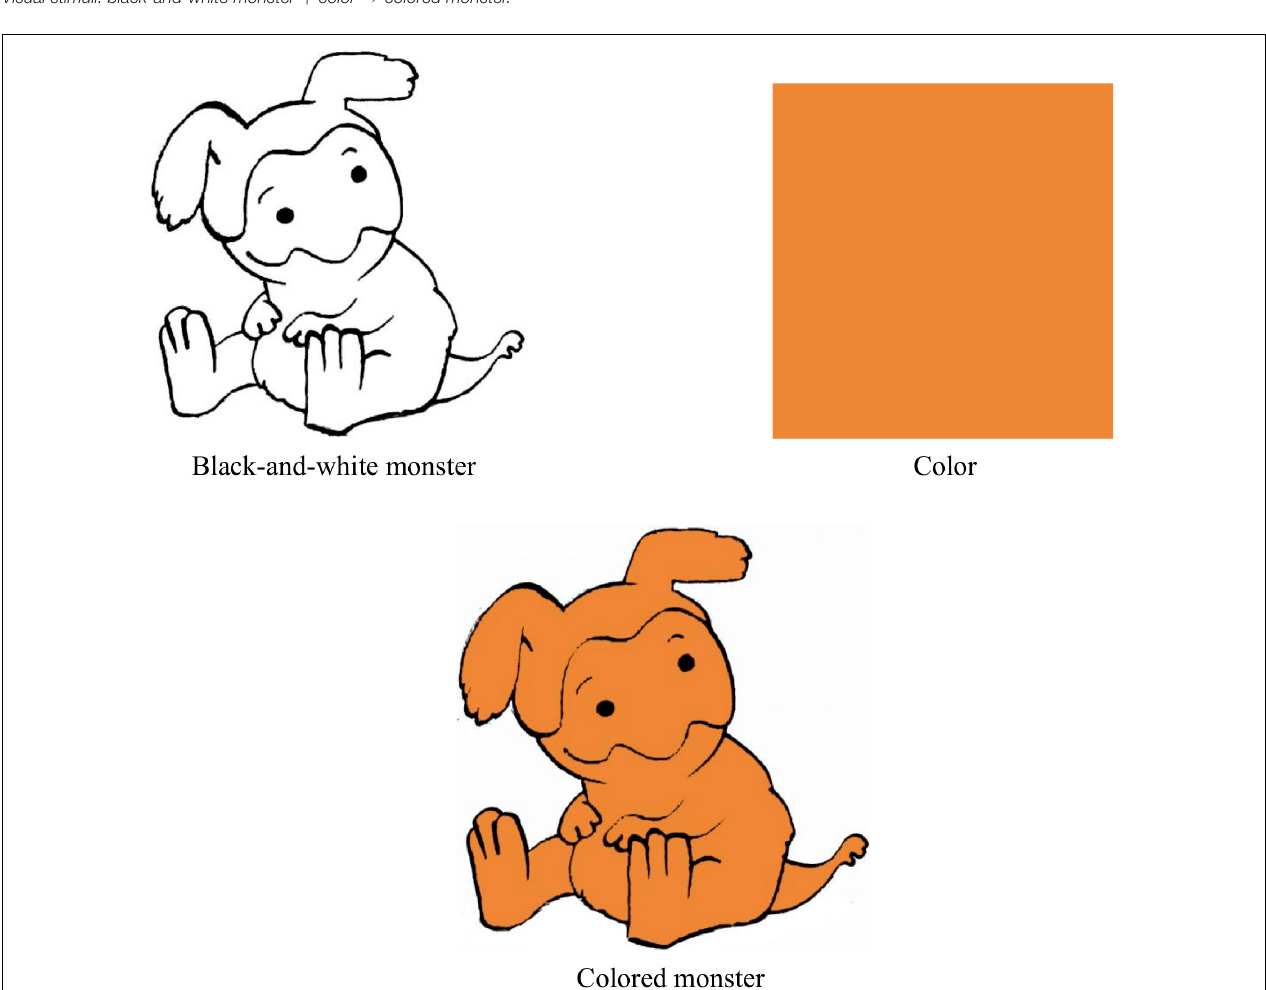
FIGURE 1 | An example of visual